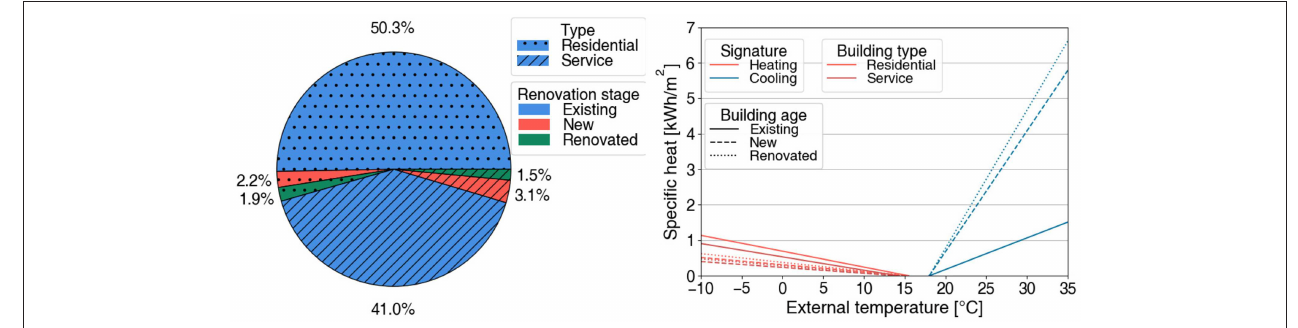
FIGURE 3 | Building distribution of a typical urban center (Left) , Heating signatures for different building types and ages (Right) .